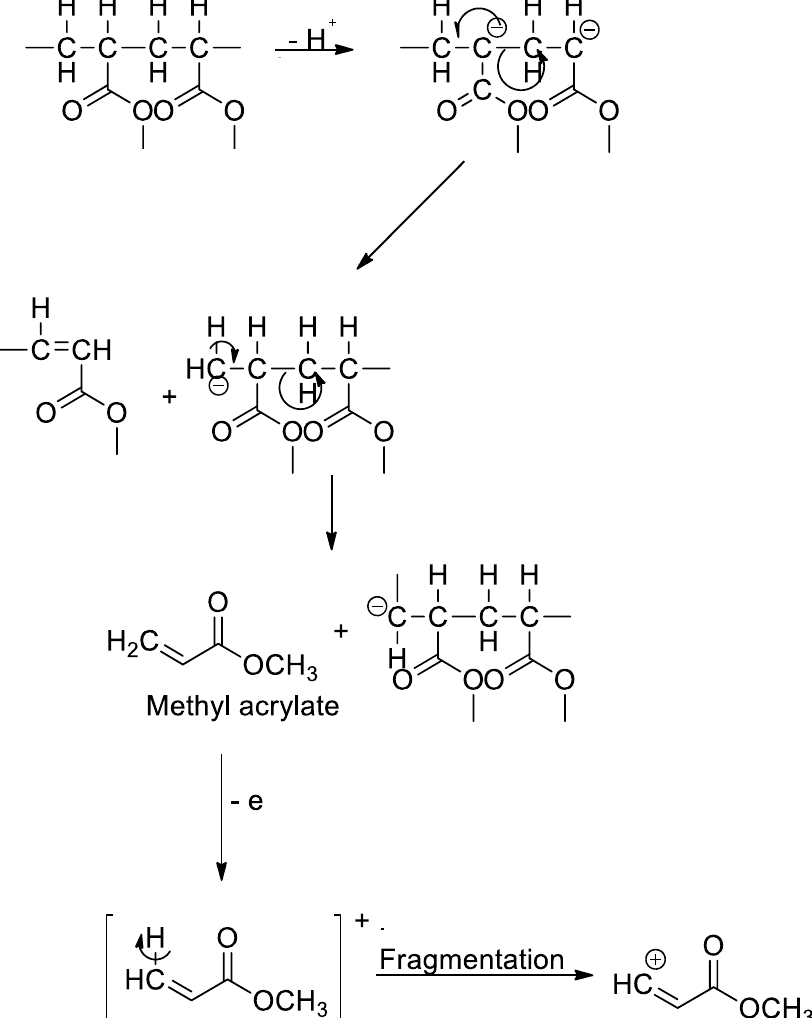
Figure 5. Fragmentation mechanism of PMMA into methyl acrylate